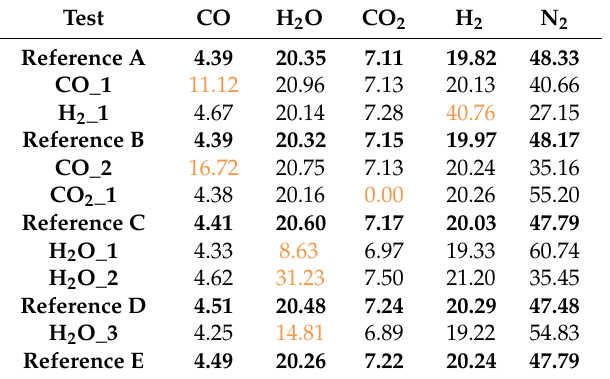
Table 3. Summary of feed composition (%) of the experiments for the kinetic study on micromonolith. Test